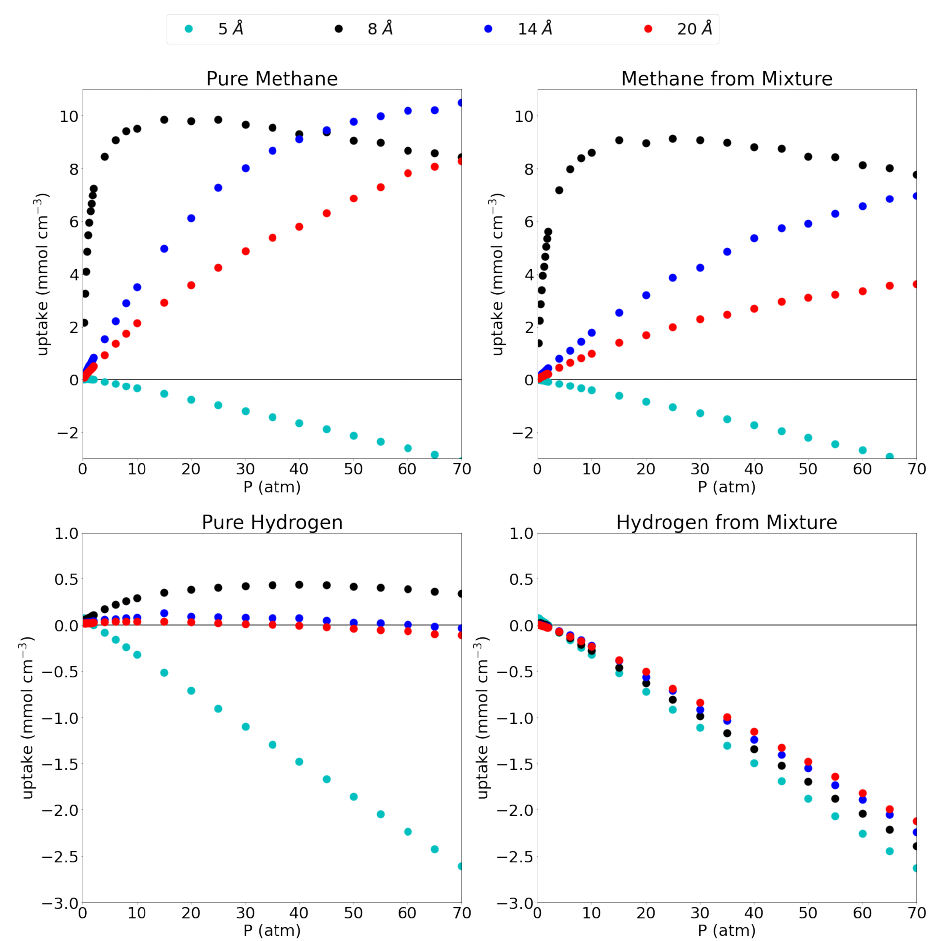
Figure 3. Excess adsorption isotherms for pure methane ( top left ), methane from the equimolar mixture ( top right ), pure hydrogen ( bottom left ) and hydrogen from the equimolar mixture ( bottom right ) at 300 K. Please notice the different scales on the y-axes. Table 4. The excess uptakes in mmol cm − 3 for the pure methane, pure hydrogen and both in